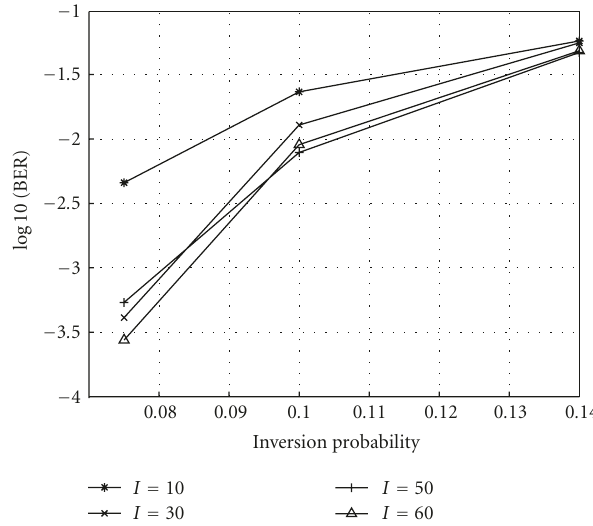
Figure 9: Number of iterations versus performance for an M = 128 LDPC-CC decoder.